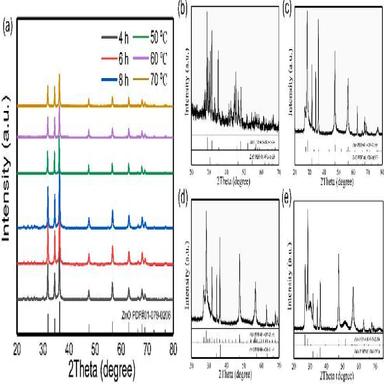
(a) XRD patterns of zinc oxide prepared at different reaction times and temperatures; (b–e) XRD patterns of products for desulfurization time of 30 h, 35 h, 40 h and 45 h.